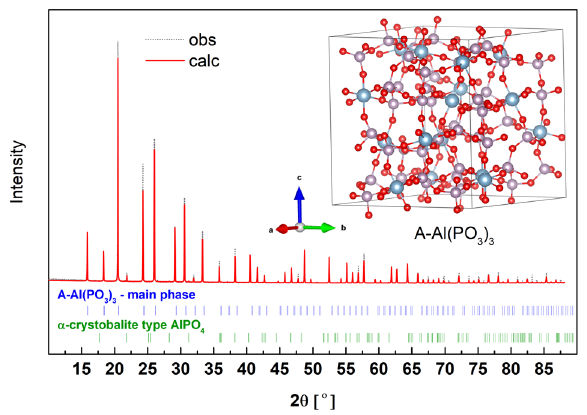
Figure 6. X-ray diffraction pattern (obs) and fit (calc) of A-Al(PO 3 ) 3 . In the inset, the unit cell of A-Al(PO 3 ) 3 with the optimized atoms’ positions.